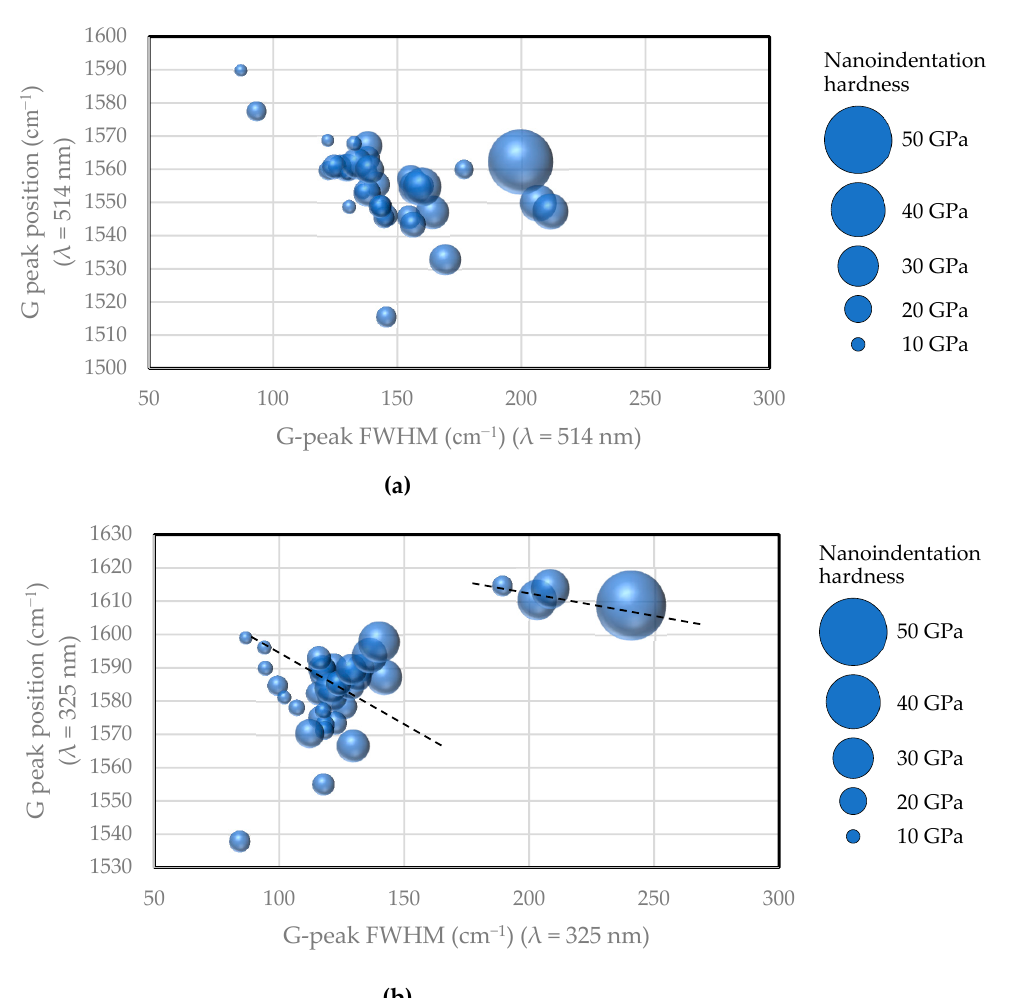
Figure 3. Nano-indentation hardness of amorphous carbon films plotted on the plane consisting of G-peak position and G-peak FWHM measured by ( a ) visible and ( b )ultraviolet (UV) light Raman spectroscopic analyses.